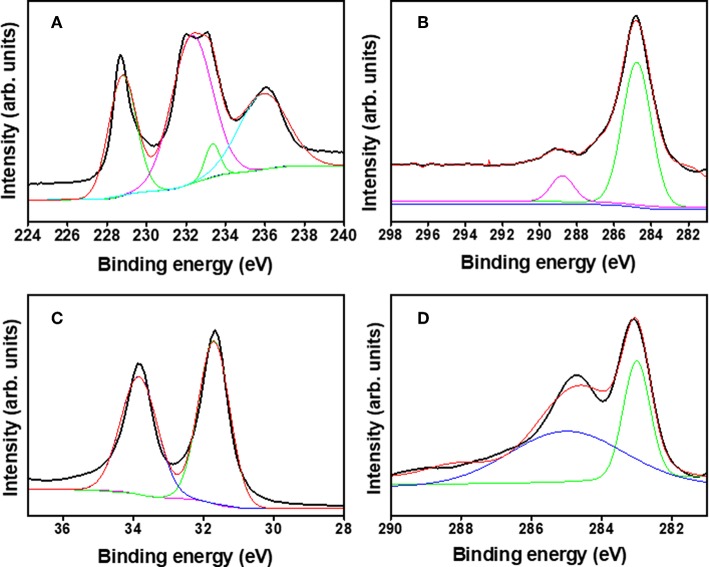
X-ray photoemission spectra: (A) Mo 3d, (B) C 1s binding energy spectra of Mo2C nanoparticles, (C) W 4f, and (D) C 1s binding energy spectra of W2C nanoparticles.